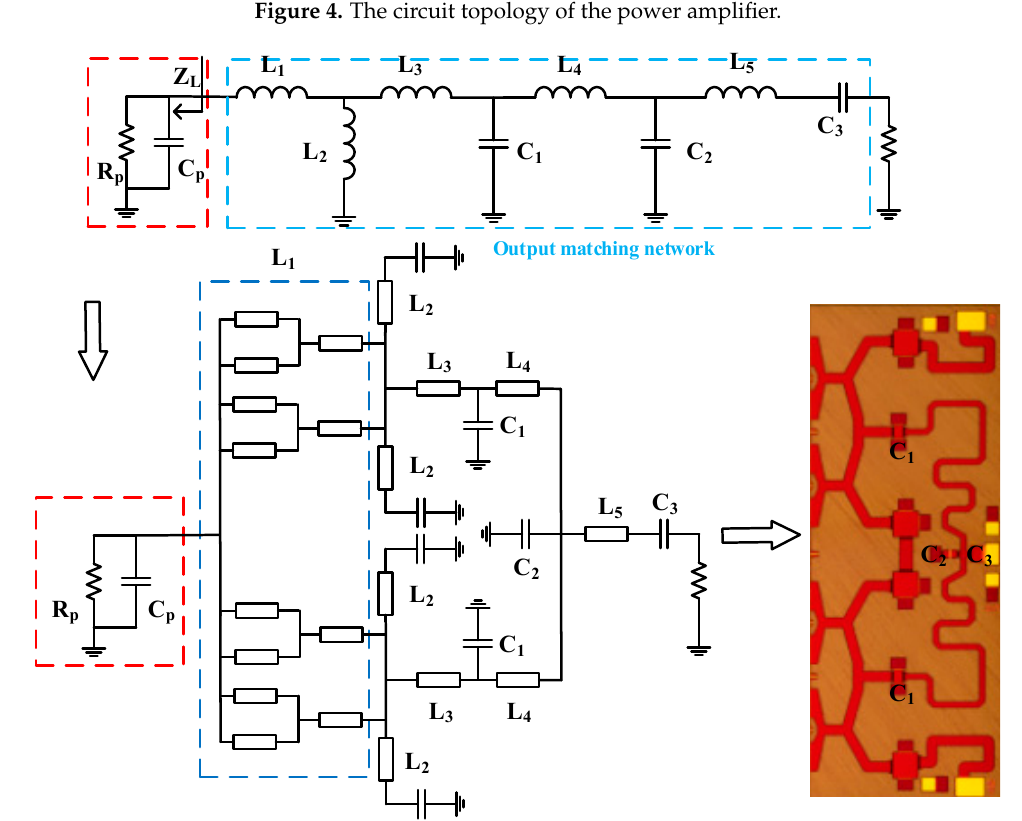
Figure 5. Output matching network.